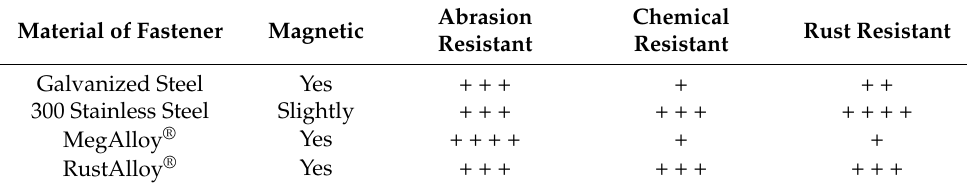
Abrasion Chemical Rust Resistant Resistant Resistant